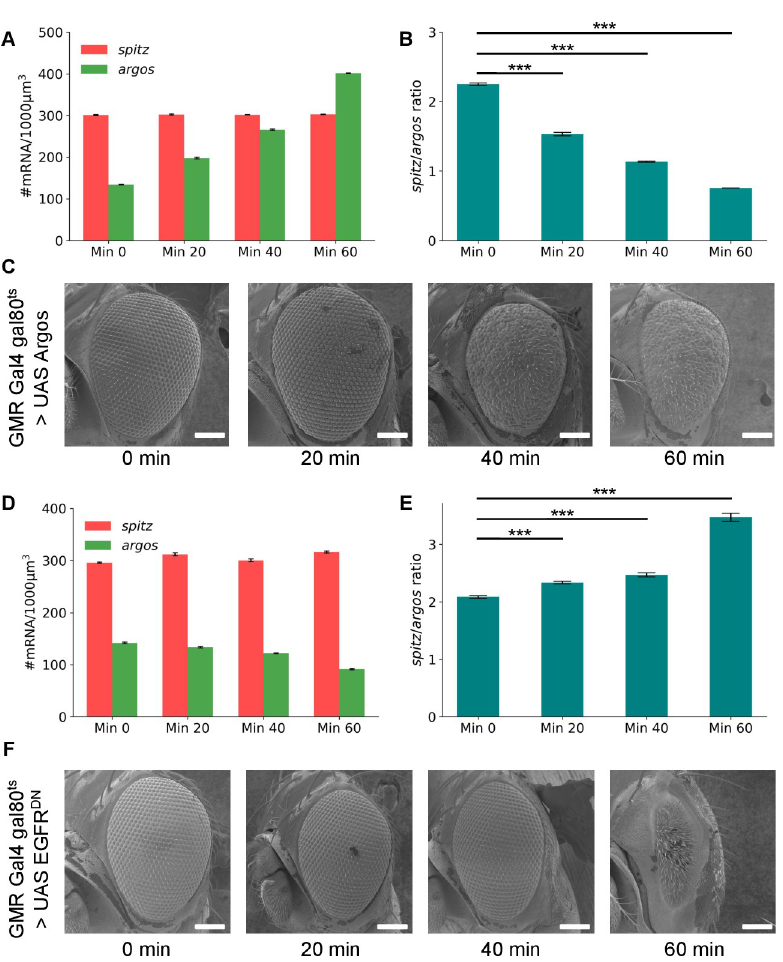
Fig 4. Binary switch in spitz -to- argos threshold range for proper patterning of ommatidia. (A) Absolute spitz and argos mRNA numbers from Gal80 ts ; GMR-Gal4 > UAS Argos progeny after different time points of heat shock at 29˚C. (B) spitz -to- argos ratios from eye discs of Gal80 ts ; GMR-Gal4 > UAS Argos progeny after different time points of heat shock at 29˚C. N = 9 tissues for all time points. The change in spitz -to- argos ratio with heatshock is significantly different irrespective of timepoints when compared with no-heatshock control (p-values < 0.001 ( ��� ) in a Student’s t- test). (C) 170X SEM images of adult eyes of Gal80 ts ; GMR-Gal4 > UAS Argos progeny at different time points of heat shock at 29˚C. (D) Absolute spitz and argos mRNA numbers from Gal80 ts ; GMR-Gal4 > UAS EGFR DN progeny after different time points of heat shock at 29˚C. (E) spitz -to- argos ratios from eye discs of Gal80 ts ; GMR-Gal4 > UAS EGFR DN progeny after different time points of heat shock at 29˚C. N = 8 tissues for all time points. Quantification of absolute mRNA numbers and ratios represented in all the above plots were calculated in the eye field irrespective of the cell type. Error bars for all the plots are standard errors of mean. The change in spitz -to- argos ratio with heatshock is significantly different irrespective of timepoints when compared with no-heatshock control (p-values < 0.001 ( ��� ) in a Student’s t-test). (F) 170X SEM images of adult eyes of Gal80 ts ; GMR-Gal4 > UAS EGFR DN progeny at different time points of heat shock at 29˚C. Scale bar for all SEM images is 100 μ m. In both cases, the final adult phenotype is robust to certain variation in the ratio threshold, and breaks down beyond resulting in fully penetrant rough eye phenotypes. It should be noted that qualitatively the roughness phenotype looks different between UAS Argos and UAS EGFR DN . The images within the figure panels are created by the authors. Scale bars in Scanning Electron Microscopy images have been provided from knowledge of pixel size and converting appropriately. Asterisks denoting significance of observed changes have been added to relevant graphs.